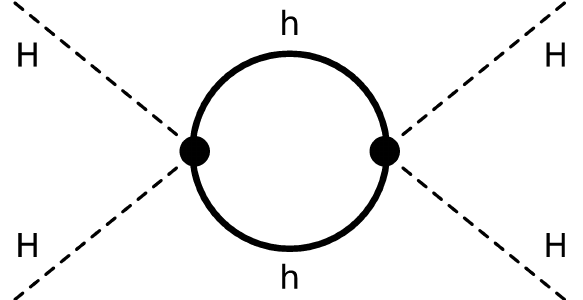
Figure 3. The main Feynman diagram containing hedgehogs in the loop, which corrects the effective Higgs